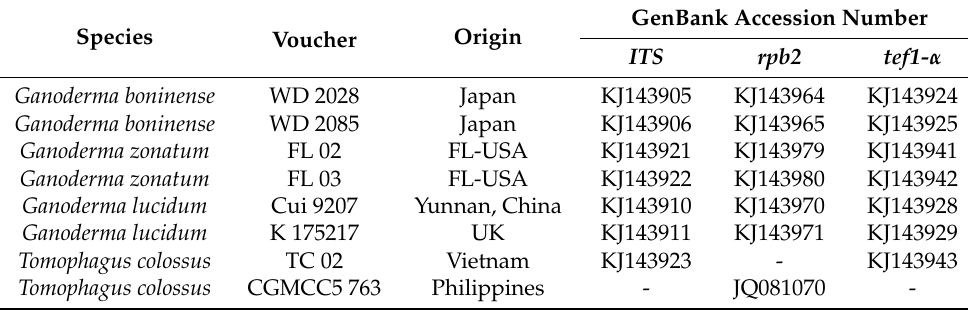
Table 1. Information on the species used in the phylogenetic analyses. Species Voucher